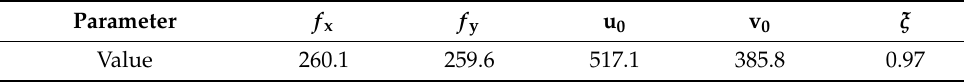
Table 2. Internal parameters of the camera in the simulation